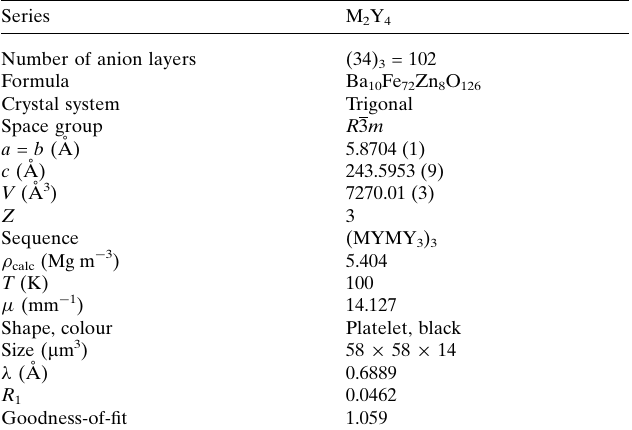
Table 5 Details of the single-crystal structure refinement for the (34) 3